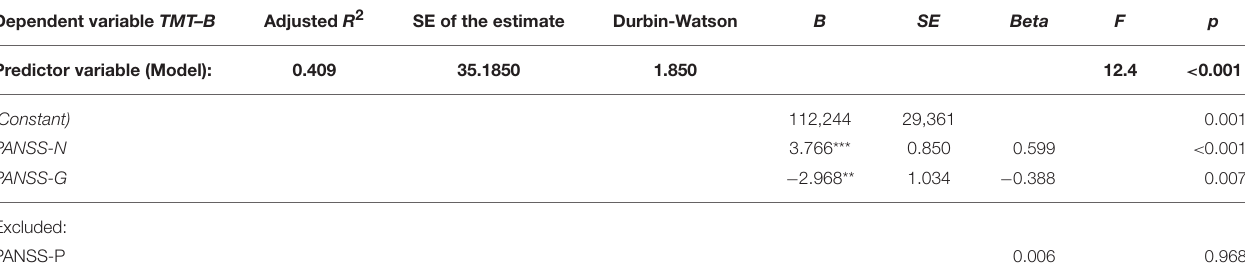
TABLE 4 | Regression model of PANSS effect (predictor) on performance in TMT B (dependent variable). Dependent variable TMT–B